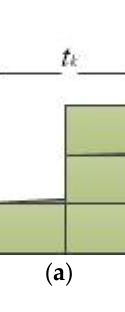
Figure 3. ( a ) Variable-in-time quay crane (QC) assignment; ( b ) time-invariant QC assignment.